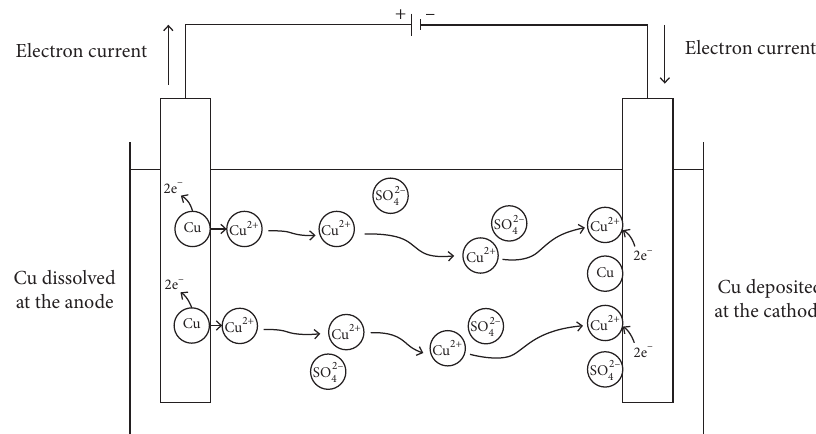
Figure 2: Diffusion of copper in copper sulphate and purification of copper.